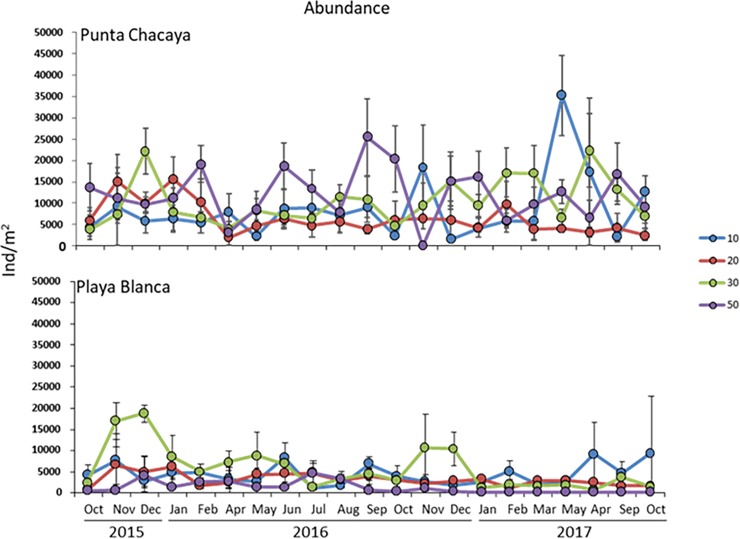
Variability in abundance.Temporal fluctuations in abundance (mean ± SD) of the macrobenthos per sampling site during the study period in Mejillones Bay. Color lines represent depth in m.